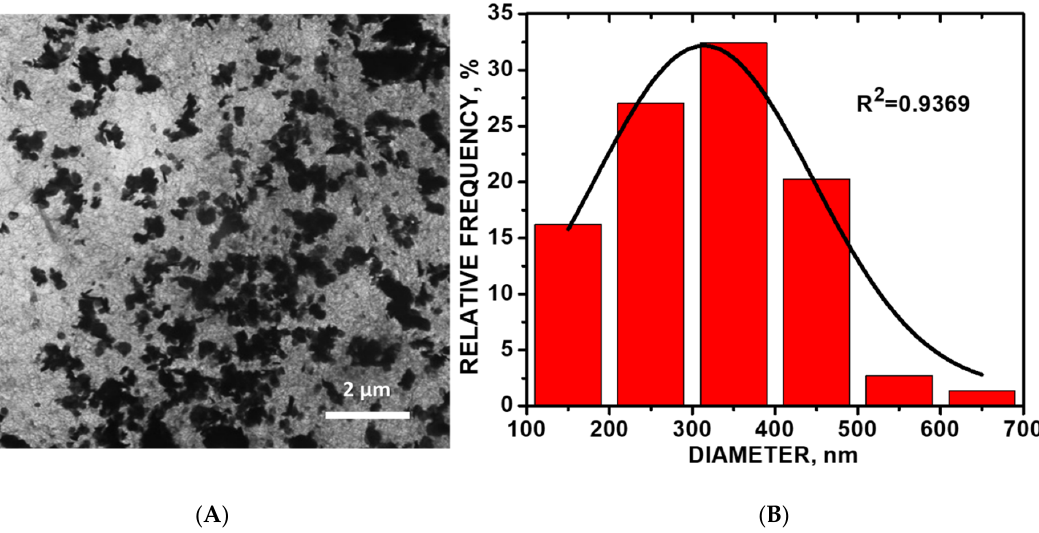
Figure 3. ( A ) Transmission electron microscopy (TEM) image of CoO/COOH-MWNT composite in absolute anhydrous ethyl alcohol solution 30-minute sonication; ( B ) size distribution histogram of the CoO particles.